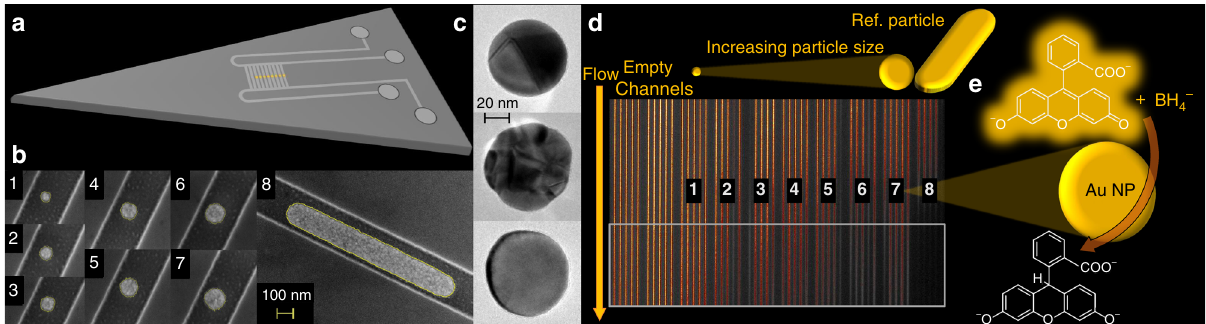
Fig. 1 Representation of the experimental setup and the studied reaction. a Schematic depiction of the nano fl uidic chip comprised of microchannels with macroscopic inlets that contact an array of two identical sets of 55 nano fl uidic channels, each decorated with a single Au nanoparticle in the center. The nanochannels are 100 nm high, 250 nm wide, and 350 µ m long. b Representative scanning electron microscopy (SEM) images of Au nanoparticles with systematically increasing sizes, taken inside a nanochannel prior to bonding of the glass lid: (1) 64 nm, (2) 82 nm, (3) 91 nm, (4) 102 nm, (5) 113 nm, (6) 121 nm, (7) 128 nm, and (8) patch of 139 × 1138 nm. c Transmission electron microscopy (TEM) images of 3 representative Au nanoparticles (~66 nm in size) after annealing (mimicking the conditions of lid bonding during assembly of the nano fl uidic device) and cleaning in a solution of 4.3 wt% ammonia and 4.3 wt% hydrogen peroxide in milli-Q water. Note the distinct structural differences in terms of grain structure and grain size, despite the essentially identical dimensions. d Fluorescence image of an array of 50 nanochannels (an additional set of empty reference channels is not shown). Each set of 5 channels with a number label is decorated with nominally identically sized (same as b ) nanoparticles. The ten empty channels to the left serve as negative control. Note the decreased fl uorescence intensity downstream of the catalyst particle position and how it varies at the single nanoparticle level. Three channels were clogged from the start (dark channels at nanoparticle sizes 2, 5, and 6) and were not evaluated. e Schematic of the reduction of fl uorescein on an Au nanoparticle catalyst, which renders the product molecule non- fl uorescent and thus generates the optical contrast for